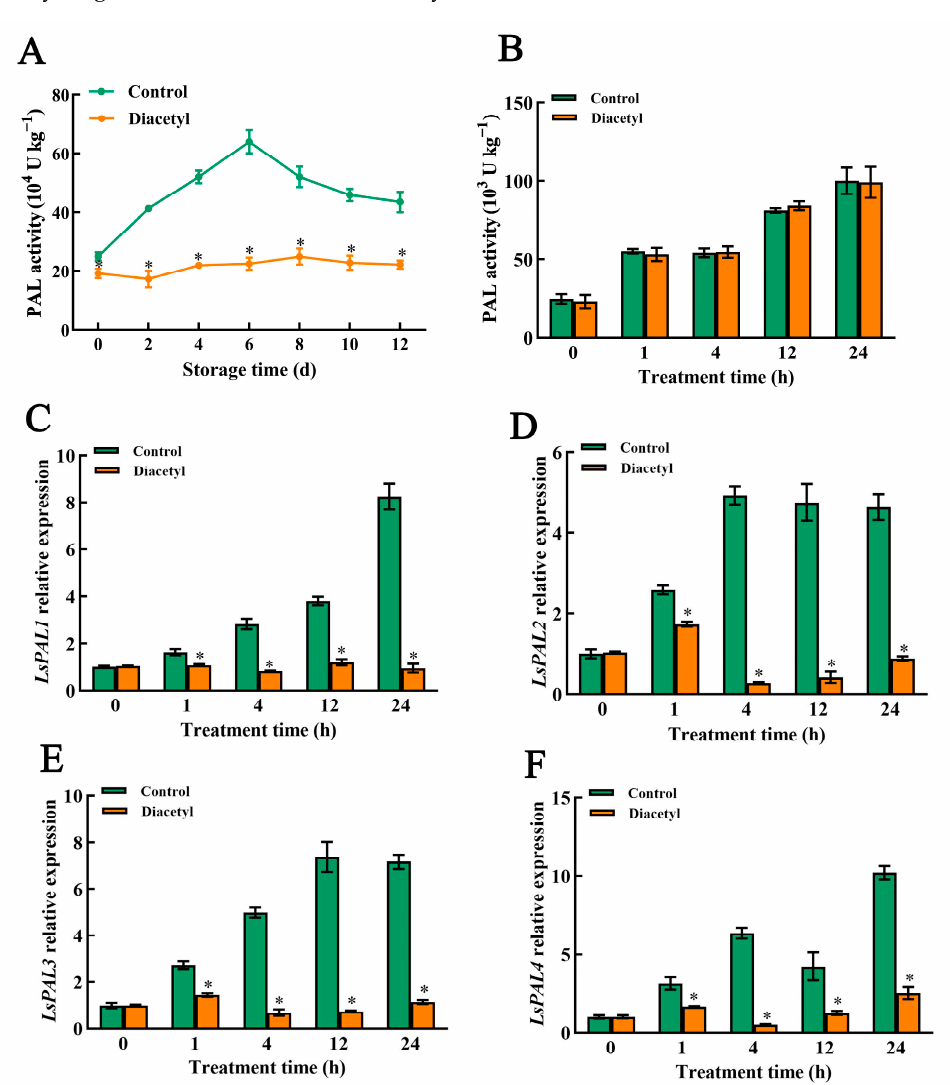
Figure 3. Diacetyl caused a great reduction in activities and expression levels of phenolic-related enzymes and genes . PAL activity in vivo ( A ), PAL activity in vitro ( B ), the gene expressions of LsPAL1 ( C ), LsPAL2 ( D ), LsPAL3 ( E ), LsPAL4 ( F ) of fresh-cut stem lettuce at 4 °C. Asterisks * indicate the significant differences ( p < 0.05) between control and treated groups in the figure at the same storage time. Vertical bars represent standard deviations.